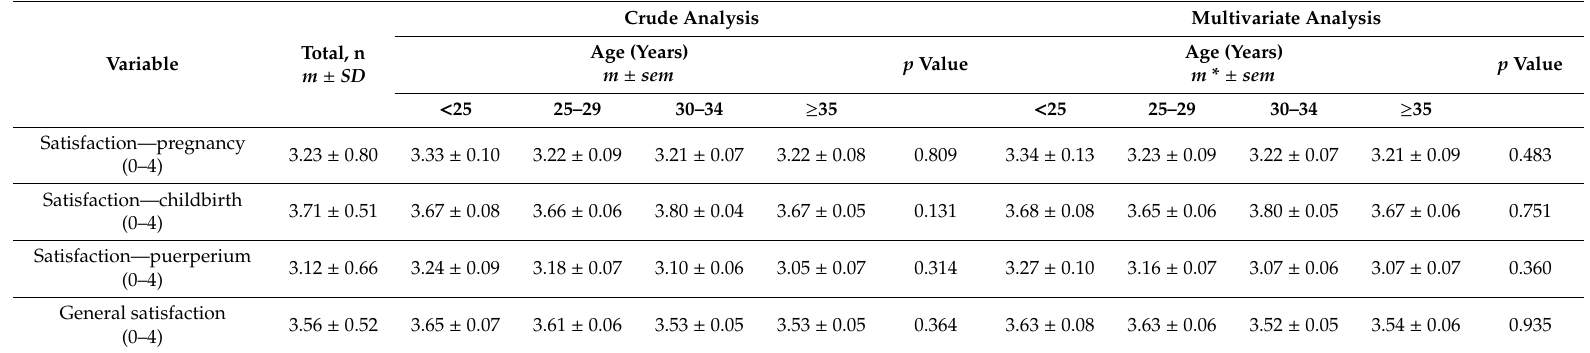
Table 3. Association between maternal age and satisfaction with the process of pregnancy, childbirth, and the puerperium stratified by age.